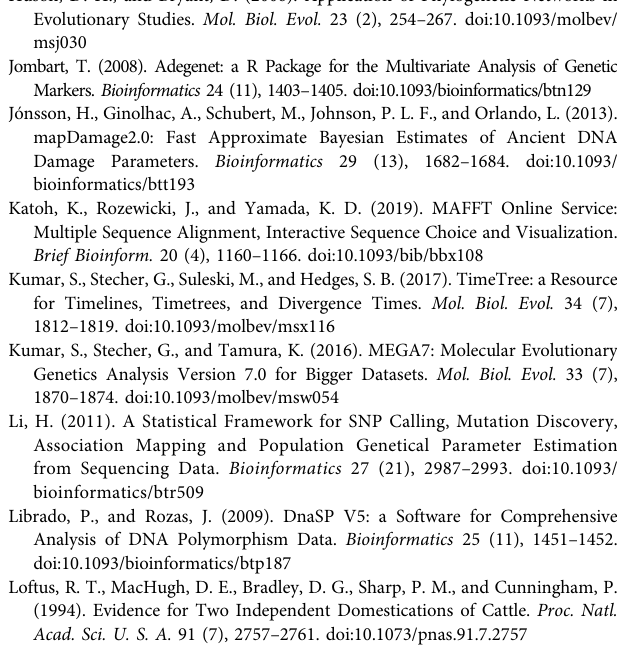
Supplementary Figure S1 | Distribution of fragment lengths of ancient DNA from three ancient samples.